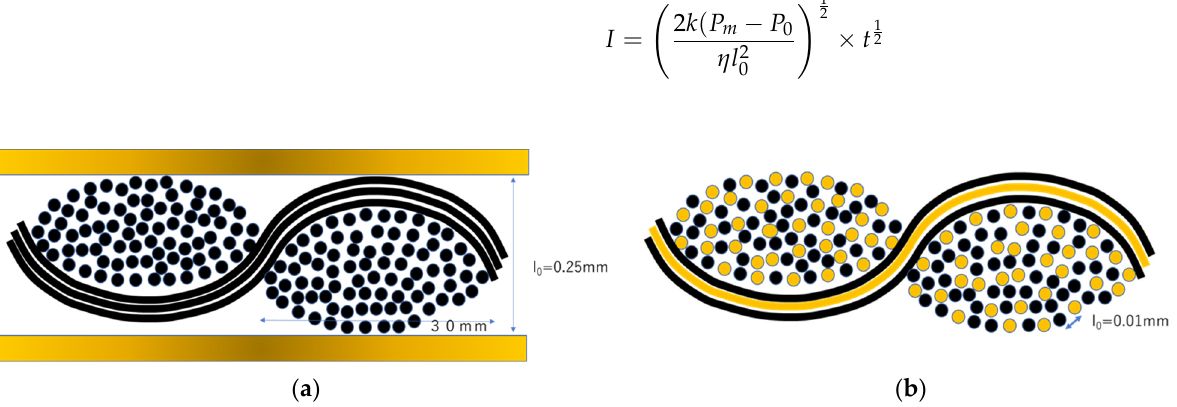
Figure 16. ( a )Molding of composite materials from carbon fiber fabric and thermoplastic film; ( b ) Molding of composite materials from commingled yarns. Figure 15. Effects of molding time and pressure on the thickness of the commingled yarn after mold- ing.